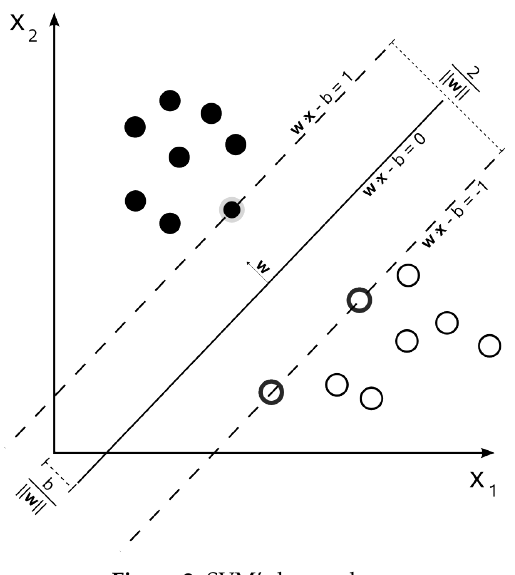
Figure 2. SVM’s hyperplane.